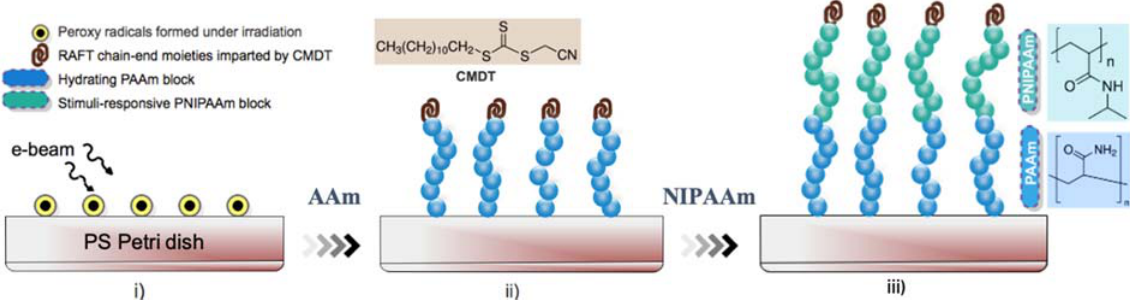
Figure 3. Modification of PS cell culture surface by consecutive grafting of PAAm and PNiPAAm via RAFT mechanism. Reprinted with permission from Ref. [85]. Copyright 2021 Elsevier. ( i ) E-beam irradiation of PS dish surface; ( ii ) Acrylamide grafting from the surface via RAFT agent CMDT; ( iii ) Chain extension by copolymerization with